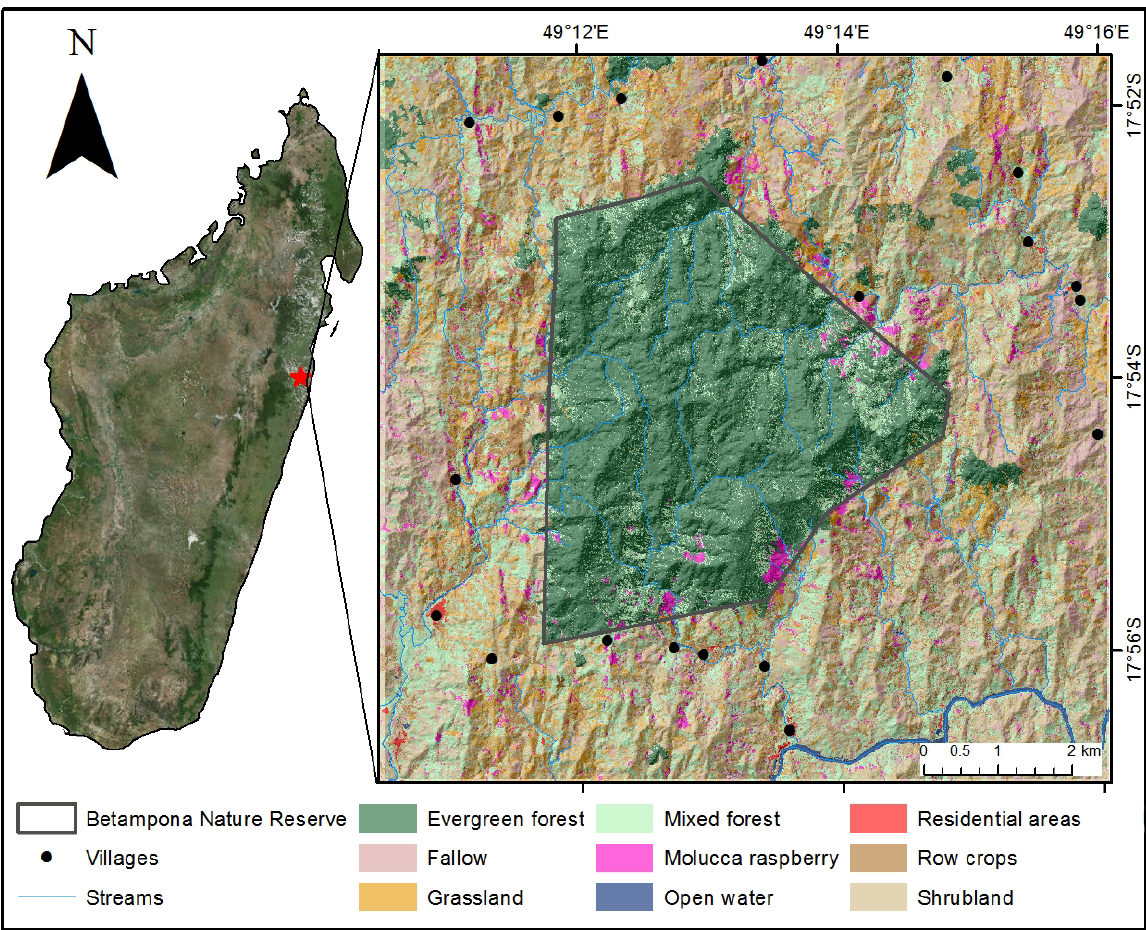
Figure 1. Location map of the study area. Land-cover/land-use (LCLU) map shown on the right is derived from IKONOS-2 multispectral imagery collected in 1 May 2010. The LCLU map is overlain on a 2 m resolution shaded relief